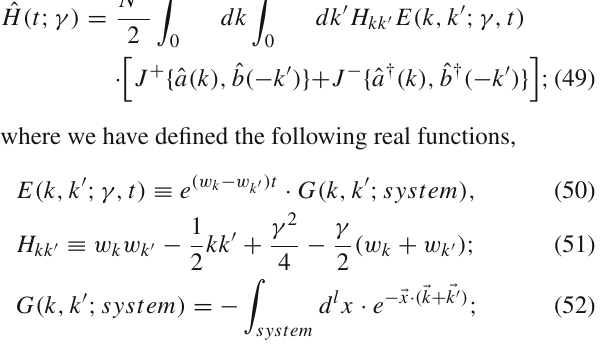
according to the red curve. The region with a nonvanish- ing i -imaginary part leads to a commutator belonging to the extended ring with two imaginary units ( i , j ) ; this quantum field theory is of interest, but it will be considered